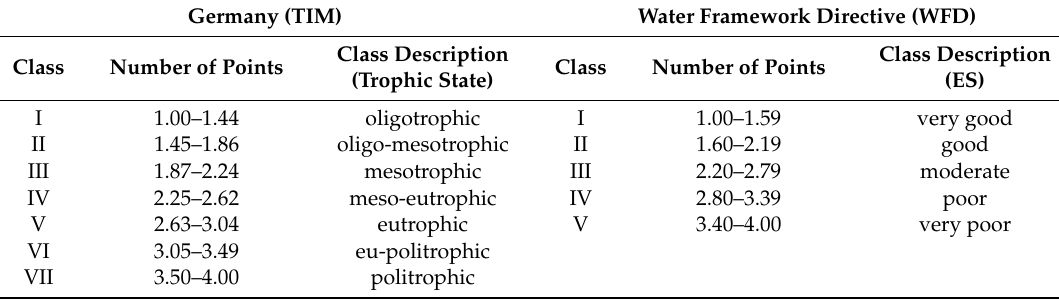
Table 1. Classification of ES according to TIM (Germany and Water Framework Directive)